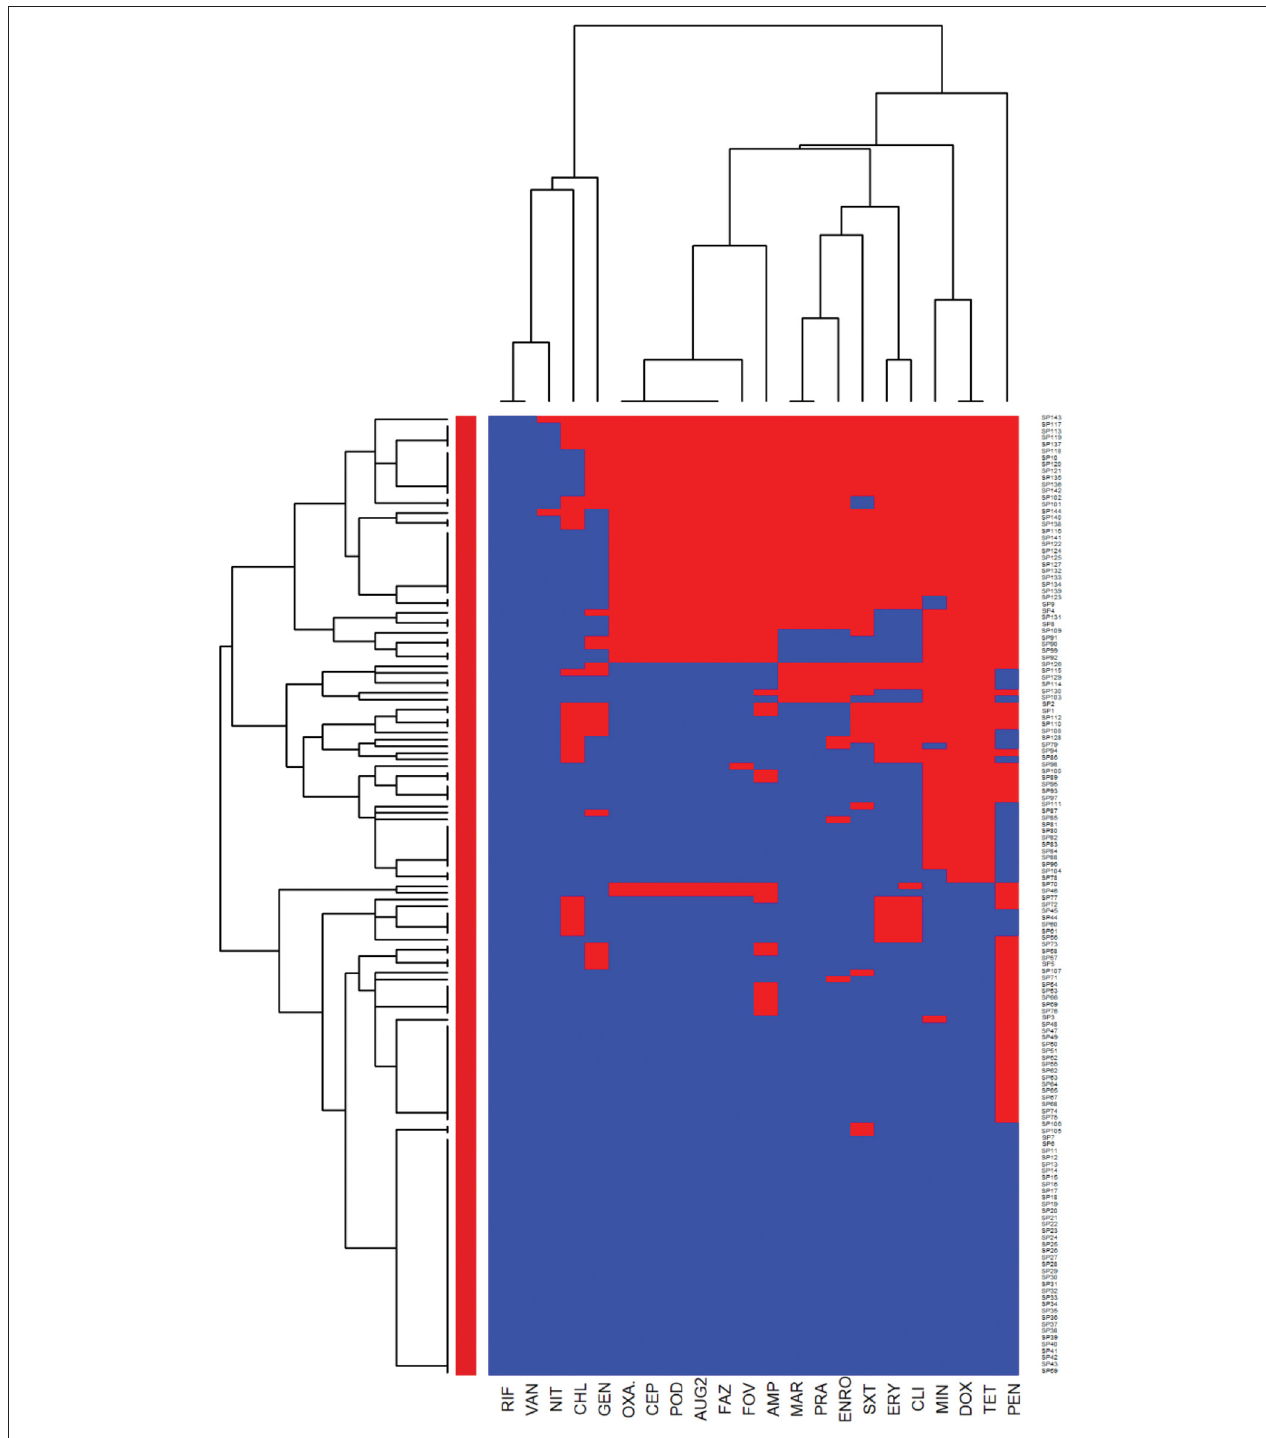
FIGURE 1 | Hierarchical clustering dendrogram of antimicrobial resistance patterns in Staphylococcus pseudintermedius isolated from canine urine samples a,b,c . a RIF, Rifampin; GEN, gentamicin; AUG2, amoxicillin-clavulanic acid; FAZ, cefazolin; FOV, cefovecin; POD, cefpodoxime; CEP, cephalothin; SXT, trimethoprim-sulfamethoxazole; ERY, erythromycin; ENRO, enrofloxacin; MAR, marbofloxacin; PRA, pradofloxacin; VAN, vancomycin; CLI, clindamycin; NIT, nitrofurantoin; AMP, ampicillin; PEN, penicillin; OXA, oxacillin; CHL, chloramphenicol; DOX, doxycycline; TET, tetracycline; MIN, minocycline. b Heatmap generated by hierarchical clustering of the antimicrobial resistance determinants (columns) of bacterial isolates (rows). c Red color, resistant; blue color, susceptible.